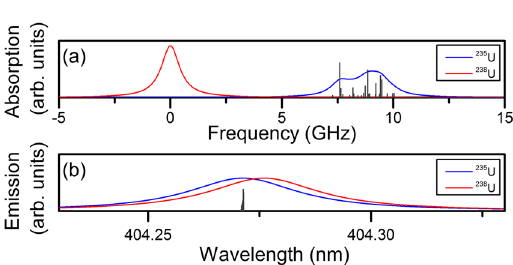
Table 1. Energy levels, total angular momenta J, isotope shifts, and hyperfine constants (A, B) for measured 235 U transitions.